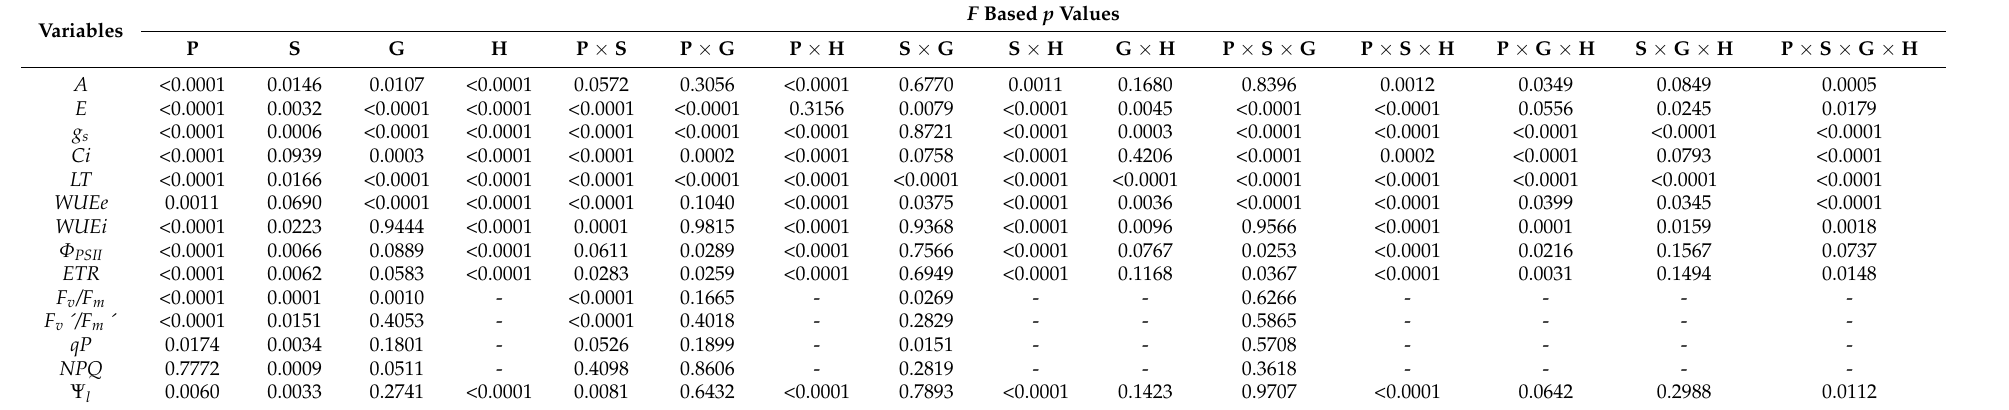
Table 2. Analysis of variance of the fixed effects on the photosynthesis-related traits at the leaf level in nine Hevea brasiliensis genotypes from the ECC-1 ( É lite Caquet á Colombia) selection and the cultivar IAN 873 (control) on a diurnal cycle in two seasonal periods at two sites with different climates in Caquet á (Northwestern Colombian Amazon). Period (P), site (S), genotype (G), hour (H), and their interactions on net CO 2 assimilation rate ( A ) ( µ mol CO 2 m − 2 s − 1 ), transpiration rate ( E ) (mmol H 2 O m − 2 s − 1 ), stomatal conductance ( g s ) (mmol H 2